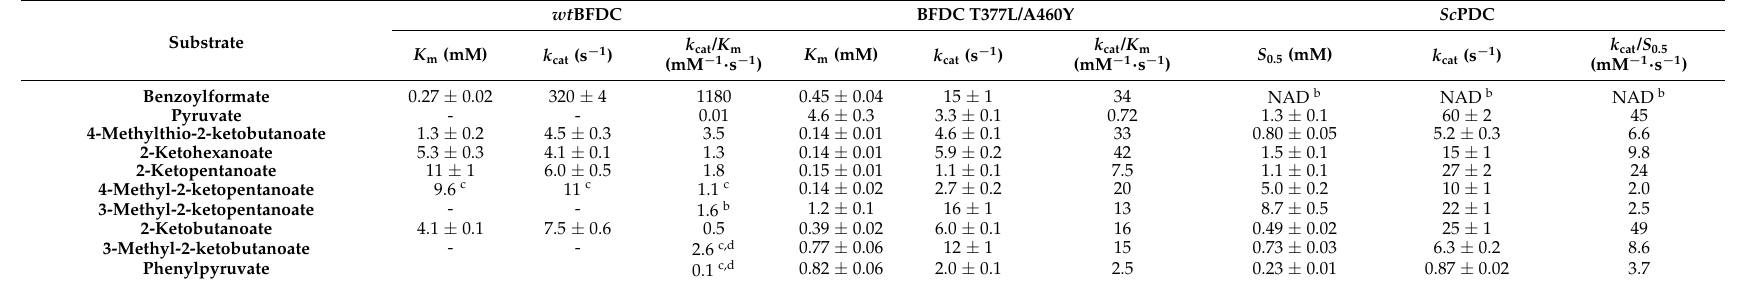
Table 1. Kinetic characterization of wt BFDC, BFDC T377L/A460Y and Sc PDC at pH 6.0 a